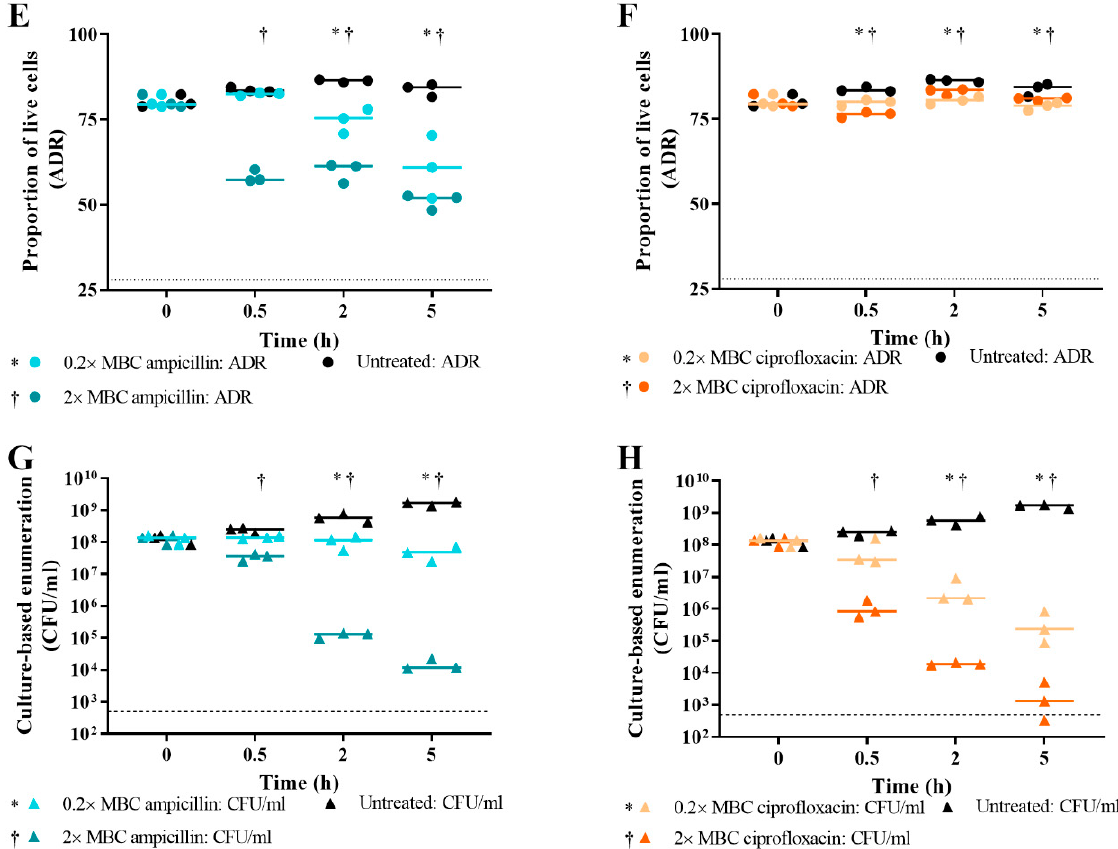
Figure 8. The impact of antibiotic concentration on E. coli live/dead spectrometry. 0 h, 0.5 h, 2 h, and 5 h time points, viability of E. coli MG1655 challenged with ~0.2 × and 2 × MBC of ampicillin (cyan and teal, respectively) and of ciprofloxacin (light orange and dark orange, respectively) and an untreated control (black) was determined by measuring fluorescence of SYTO 9-, PI-, and SYTO 9- and PI-stained cultures using the Optrode and by culture-based enumeration ( G , H ). Fluorescence intensities were obtained from integrating 505–515 nm for green emissions and 600–610 nm for red emissions. The proportion of live cells in the sample population was determined by the impact of the quenching/enhancement dye interaction on green emissions ( A , B ); level of red emissions ( C , D ); and the adjusted dye ratio (ADR; E , F ). The dotted lines represent the equivalent value for isopropanol-killed cells. The limit of detection for viable cell plate counts is 500 CFU/mL (dashed line). Data presented is from three biological replicates with a line plotted at the median. Statistical significance for the difference between ~0.2 × MBC treated and untreated is represented by * and between ~2 × MBC treated and untreated is represented by † (two-way RM ANOVA, p value: <0.05, Tukey multiple comparisons